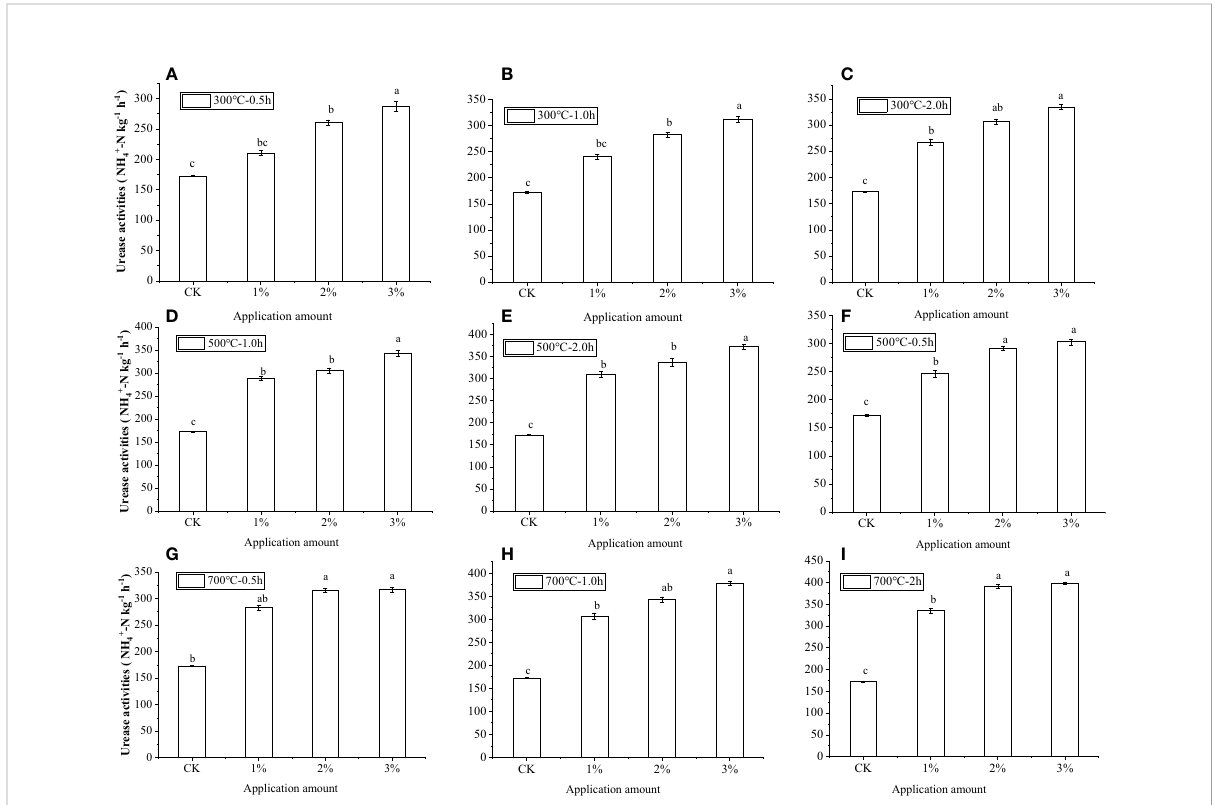
FIGURE 5 Comparison of urease activities before and after application of water hyacinth biochar. Small letters indicates signi fi cant